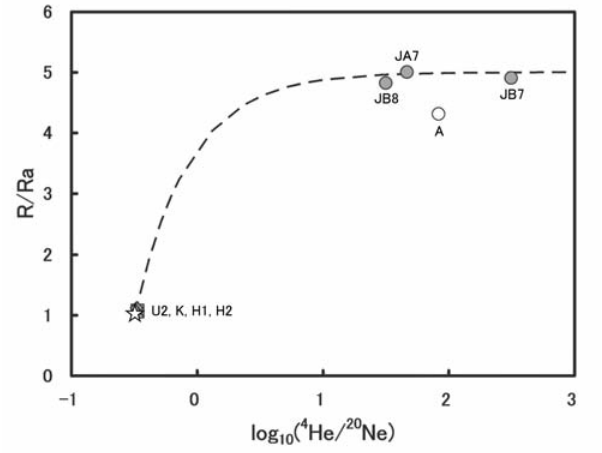
Figure 6. 3 He/ 4 He versus 4 He/ 20 Ne ratios of the fumarolic gases. R and Ra, 3 He/ 4 He ratios of fumarolic gas and air (1.4 × 10 –6 ), respectively. Dashed curve, mixing line between air and an end member with an R/Ra of 5 and a 4 He/ 20 Ne of 1000.